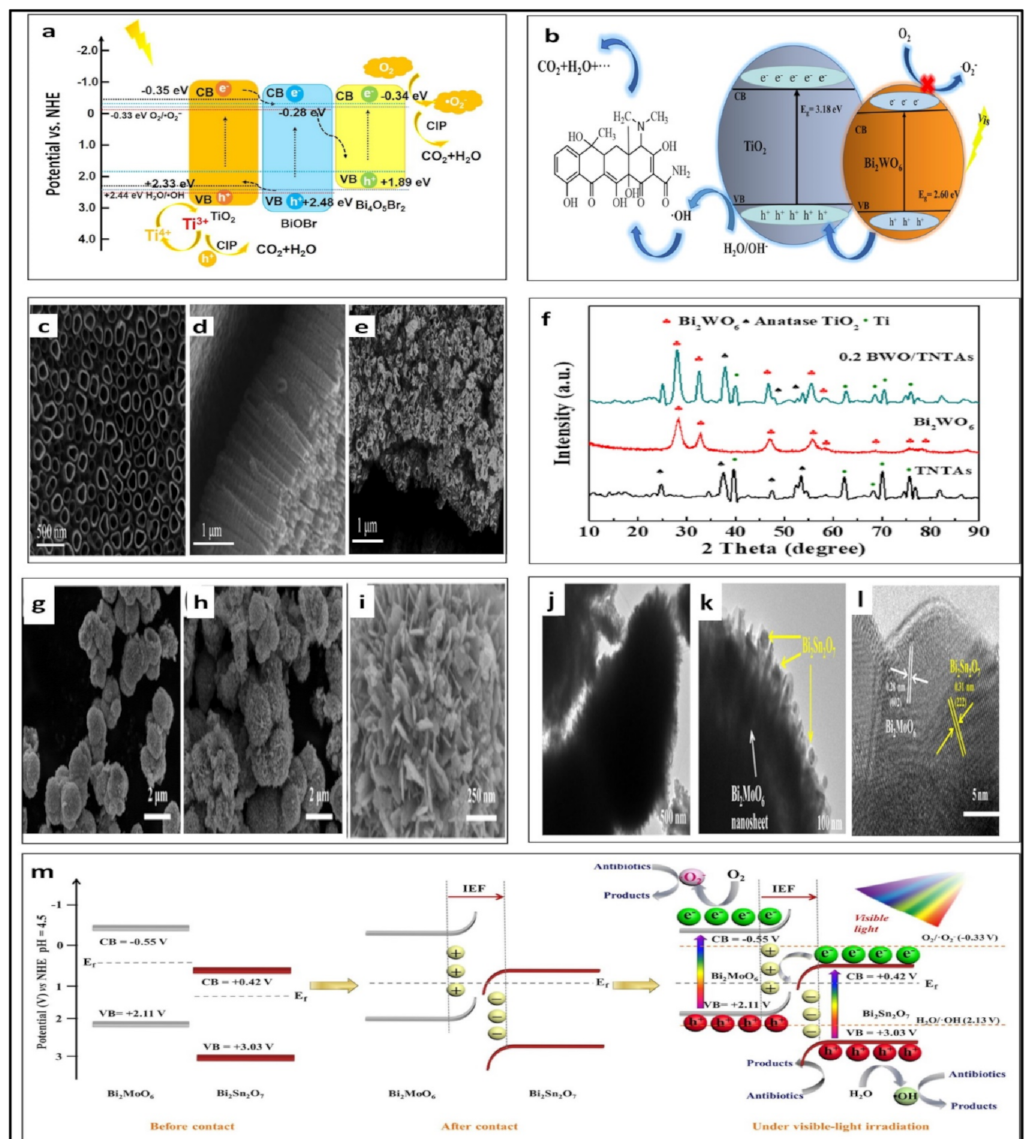
Figure 4. ( a ) Proposed photocatalytic mechanism for the photodegradation of CIP (reprinted